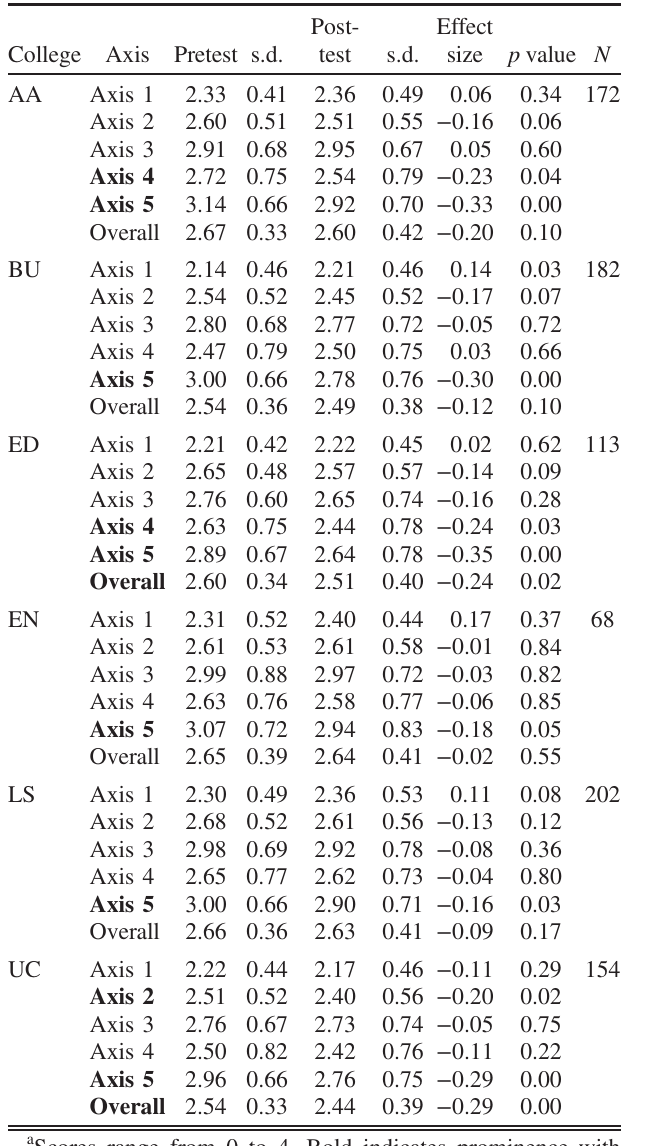
TABLE IV. EBAPS pretest and post-test results for baseline by college. a